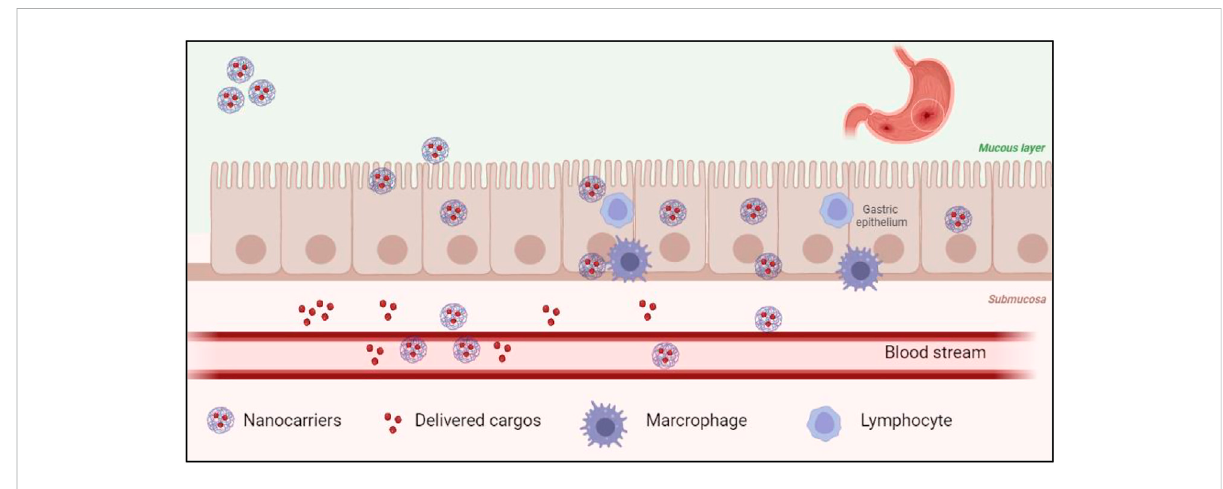
FIGURE 2 Biological barriers exist in nano-cargo delivery at the GI